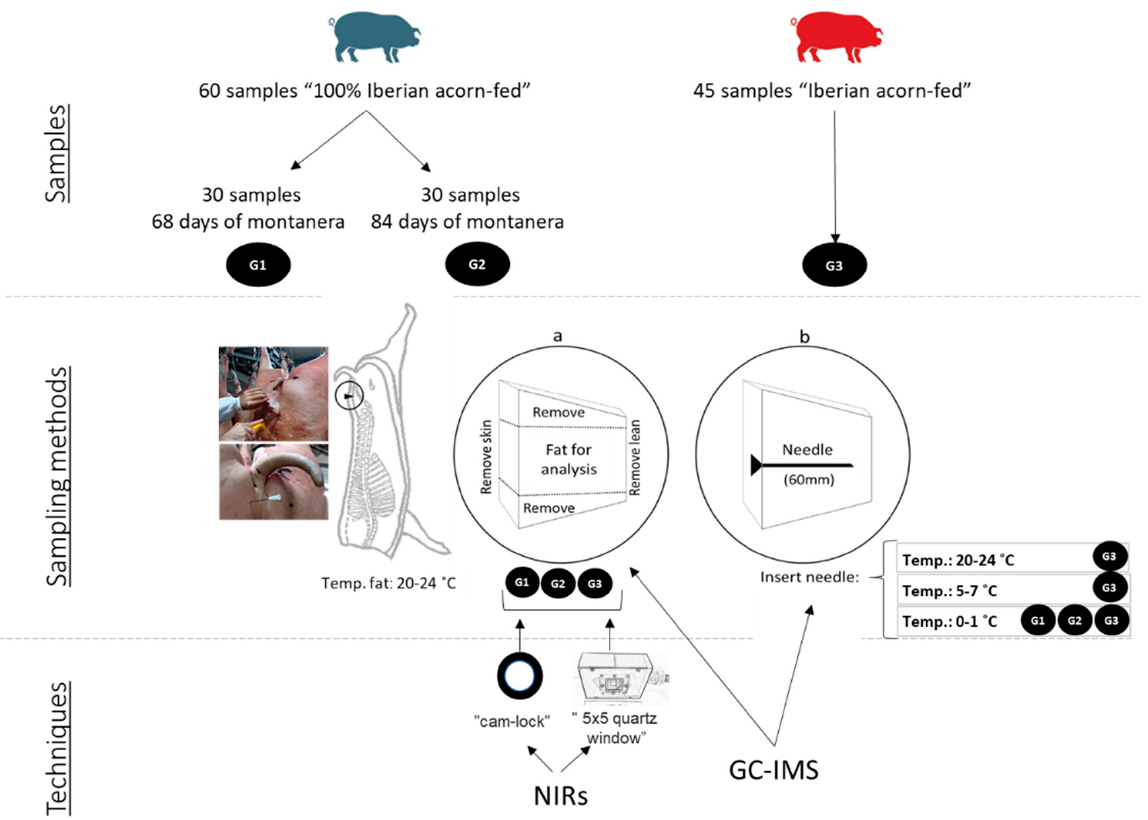
Figure 1. Sampling methods for subcutaneous fat: ( a ) standardized method; ( b ) samples taken with needles.